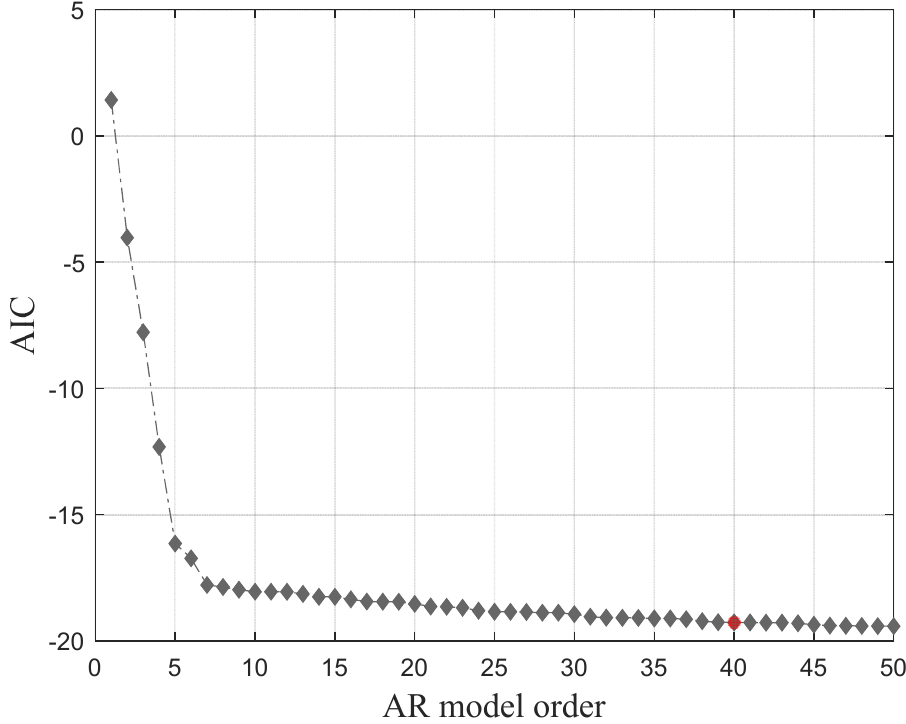
Figure 7. AR model order definition.